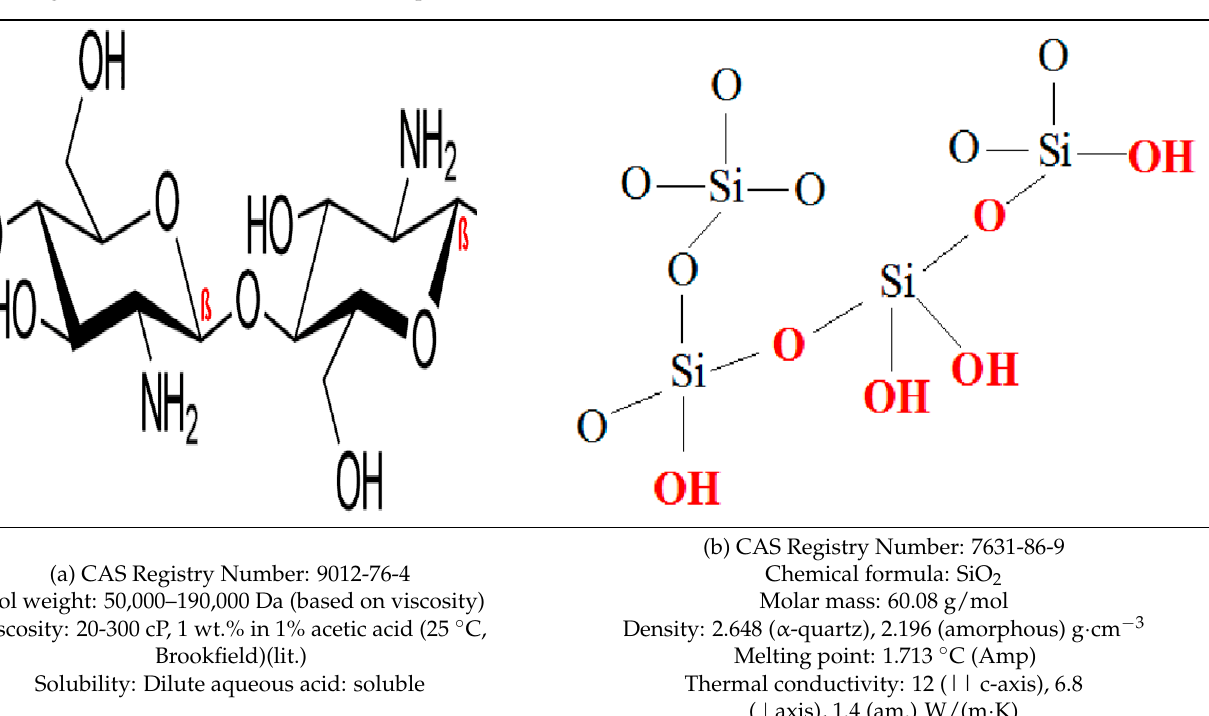
Table 1. Structure and properties of the key elements used for preparing films: (a) chitosan (b) nano/SiO 2 (c), and nisin for evaluating the antimicrobial effect on cantaloupe fruit.